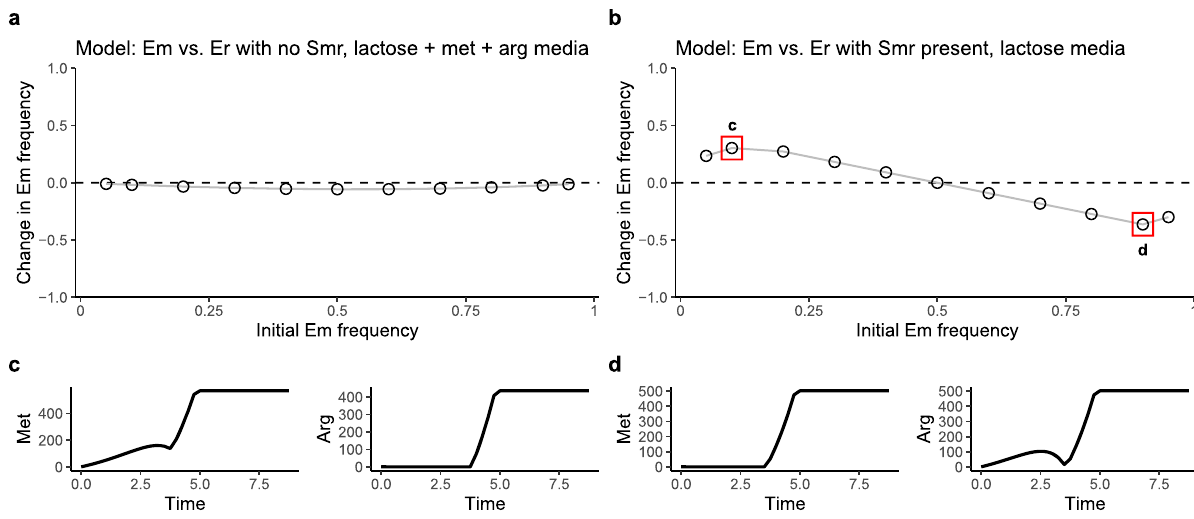
Fig. 3 A resource-explicit ecological model shows that temporary limitation by different resources promotes coexistence. a In an Em + Er coculture in an environment with lactose, methionine, and arginine, Em decreases across a range of initial frequencies, indicating that Er is the stronger competitor and that the two strains cannot coexist. b In a community of Em, Er and Smr in a lactose environment, both Em and Er are able to increase in frequency when initially rare, which indicates coexistence through negative-frequency dependence. c Dynamics of methionine and arginine at the left data point boxed in red in part b , where Em begins at 10%. During early timepoints, methionine is not limiting, while arginine is limiting. Growth ceases when lactose is depleted, and dynamics of the three strains and all resources are shown in Supplementary Fig. 9. d Dynamics of methionine and arginine at the right data point boxed in red in part b , where Em begins at 90%. During early timepoints, arginine is not limiting, while methionine is limiting. The dynamics of strains and all resources are shown in Supplementary Fig. 10. Source data are provided as a Source Data fi